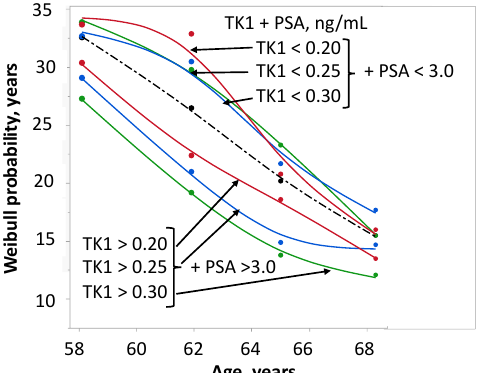
9 of 18 Figure 7. Influence of PSA concentration on survival probability of 175 men with prostate cancer stratified by age. The survival probability was calculated from Weibull-transformed Kaplan – Meier estimates. The shattered line shows the survival probability of age alone. 2.5. Survival in Relation to TK1 + PSA and Age To further explore the feasibility of using PSA and TK1 in combination as a prognos- tic marker, we varied the cut-off value for PSA in the range between 2.0 and 5.0 ng/ml and evaluated the influence of various PSA concentrations on OS in TK1 + PSA group 1 (LowTK1 + LowPSA) and group 4 (HighTK1 + HighPSA). A fixed cut-off concentration for PSA of 3.0 ng/ml was used in further analysis of TK1 + PSA. In screening efforts, this specific cut-off is often used to prompt further clinical evaluation [2,4]. The cohort was further sub-grouped with three alternative cut-off values for TK1: